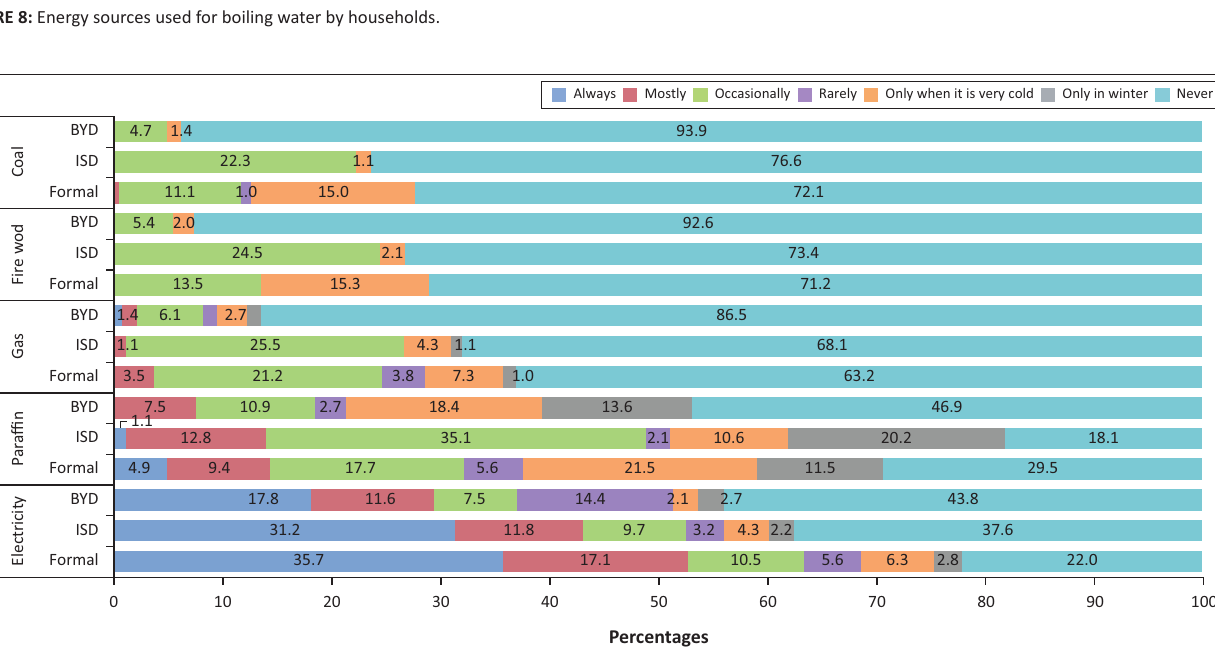
FIGURE 9: Energy sources used for heating by